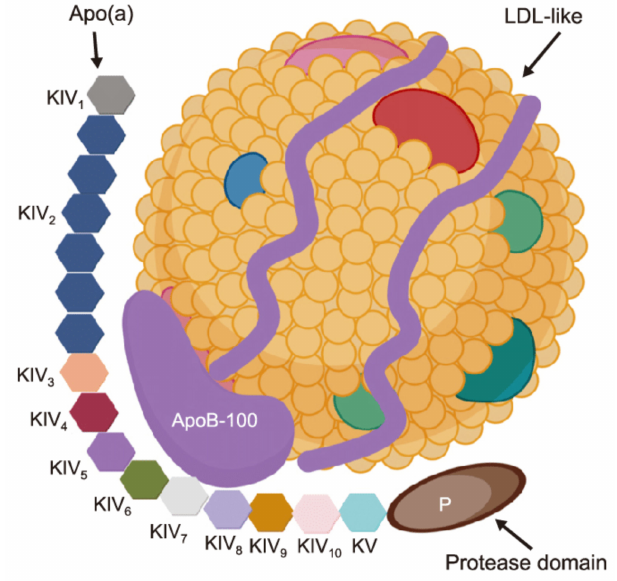
Figure 1. Lipoprotein(a) [Lp(a)] structure. Created with BioRender.com. Reprinted from Ref.